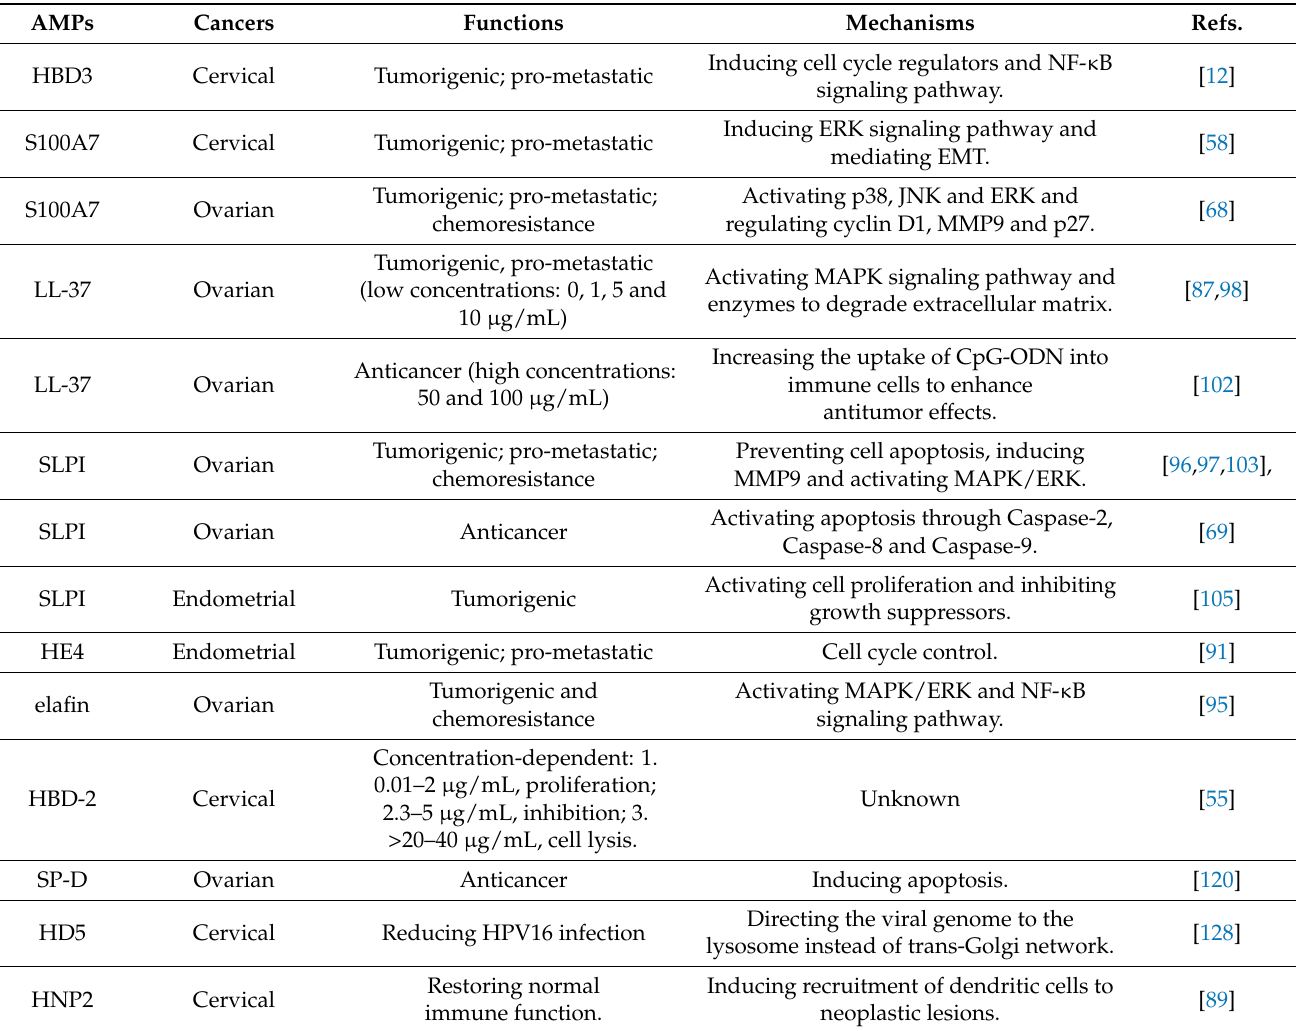
Table 3. Activities of AMPs in gynecological